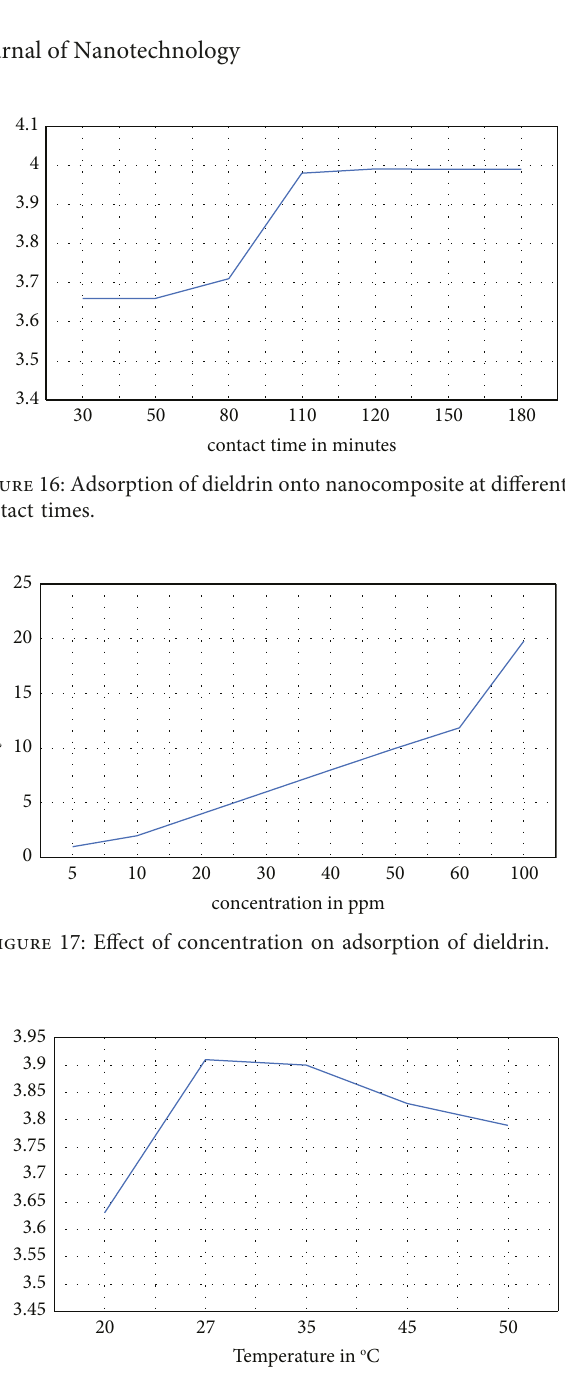
Figure 18: Effect of temperature on the adsorption of dieldrin onto nanocomposite (adsorbent dosage � 0.1g/20 mL, pH � 7.0, contact time � 120min).